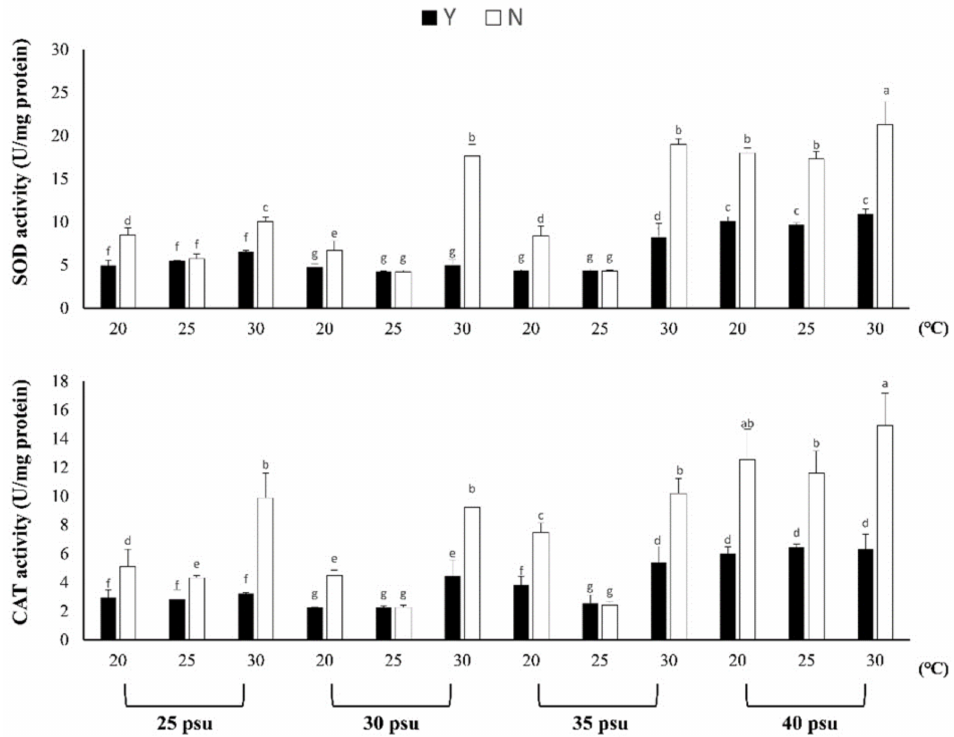
Figure 2. The effect of feeding on Briareum violacea SOD and CAT under temperature and salinity stress. Different Latin alphabet letters indicate significant differences among groups ( p < 0.05). The values are expressed as the means ± SDs ( n = 30 colonies). Y: feeding treatment